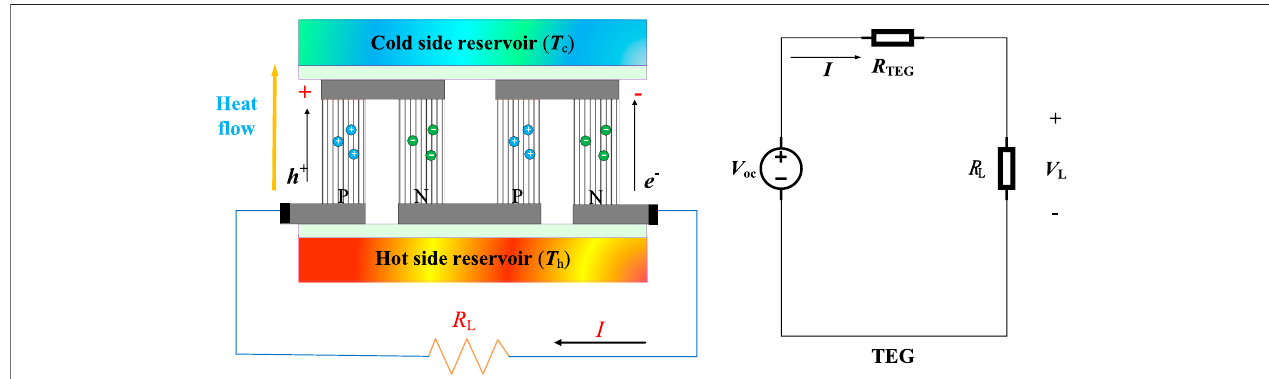
FIGURE 1 | Equivalent circuit of a TEG block.